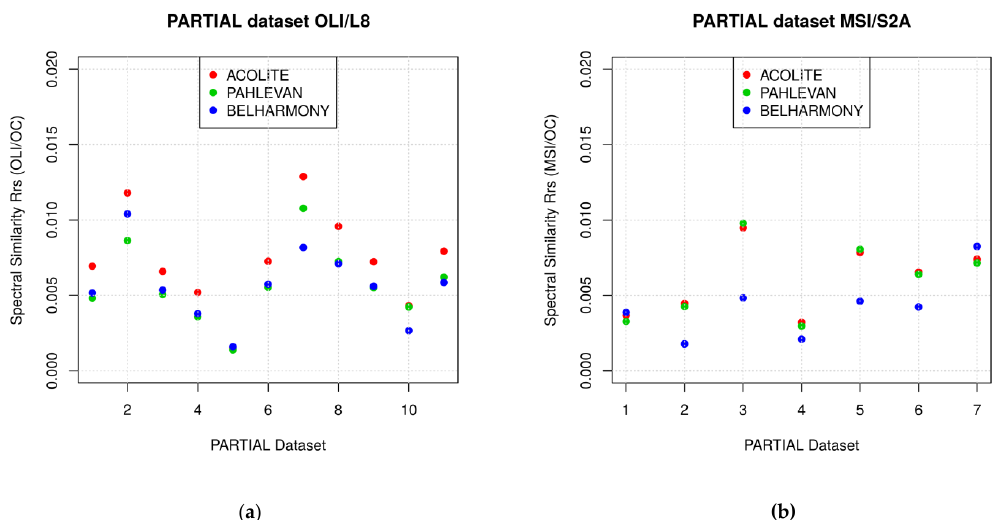
Figure 8. Spectral similarity of the Rrs provided by AERONET-OC and obtained by ACOLITE with Pahlevan and Belharmony gains and without gains for ( a ) OLI/L8 and ( b ) MSI/S2A.